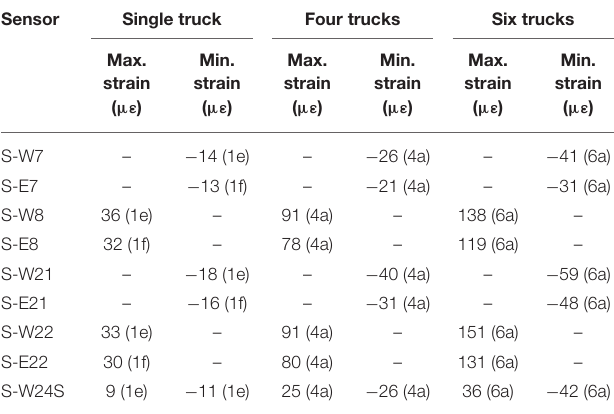
TABLE 2 | Baseline response peak strain.